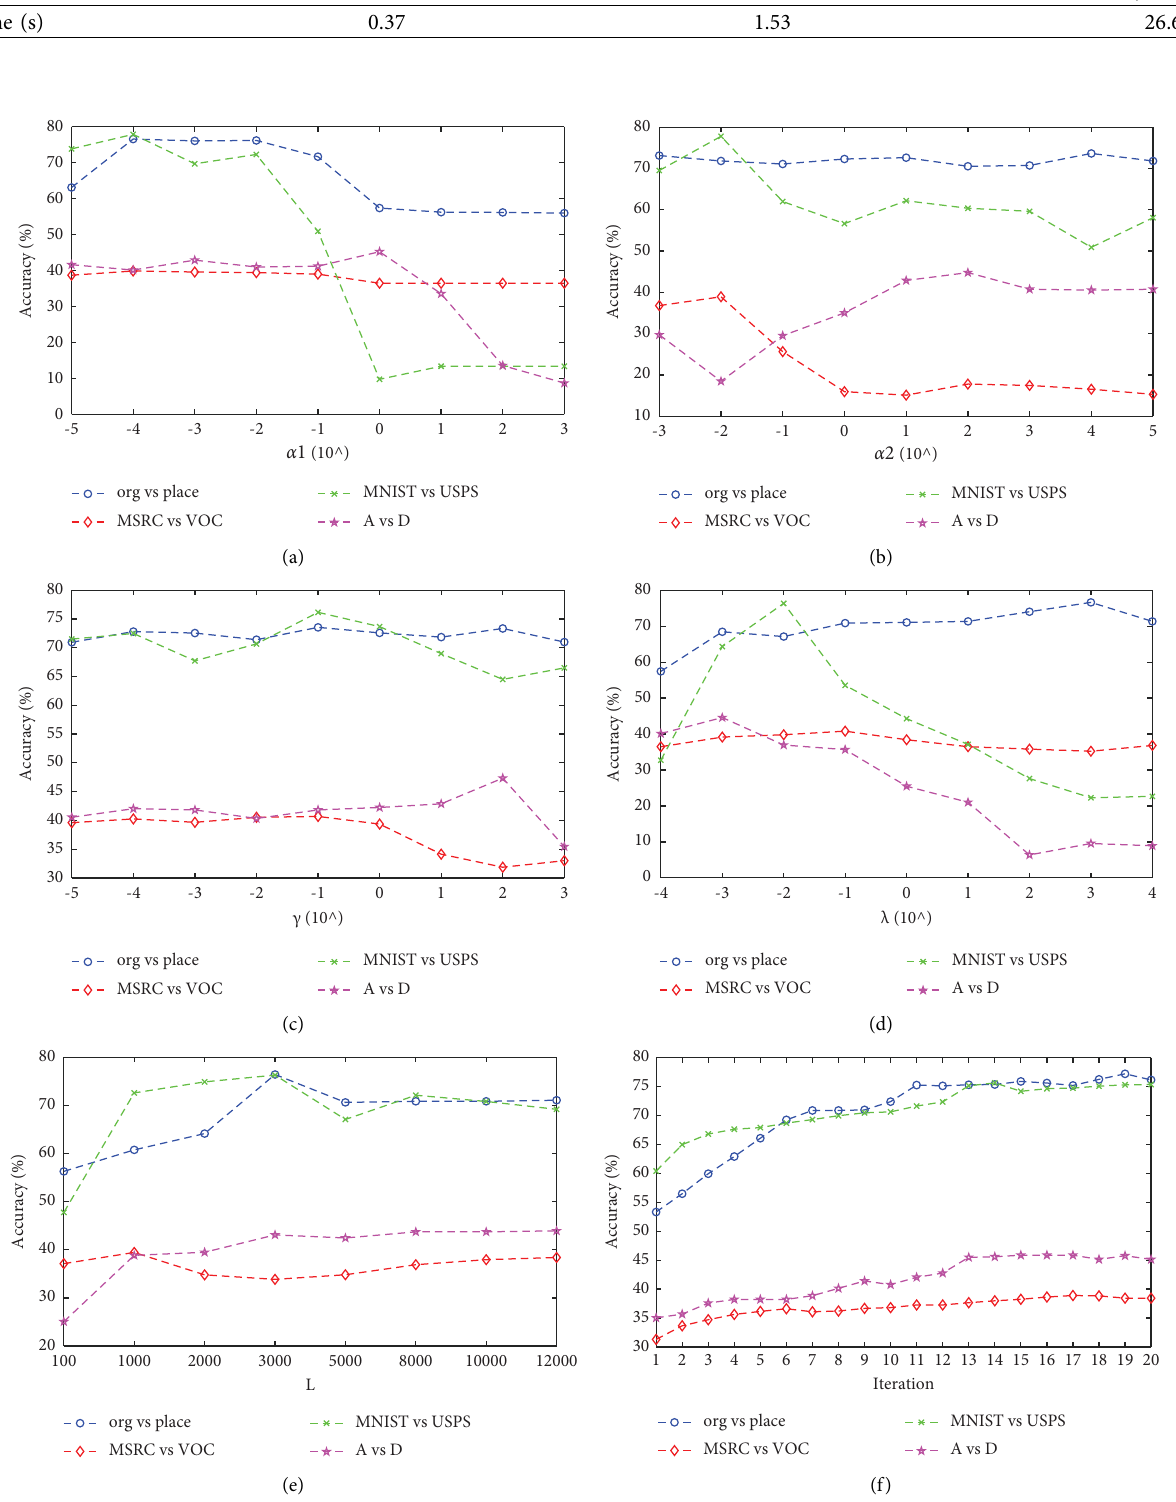
Figure 5: Classifcation accuracy vs. number of hidden-layer nodes ( L ) , iterations, and parameters α